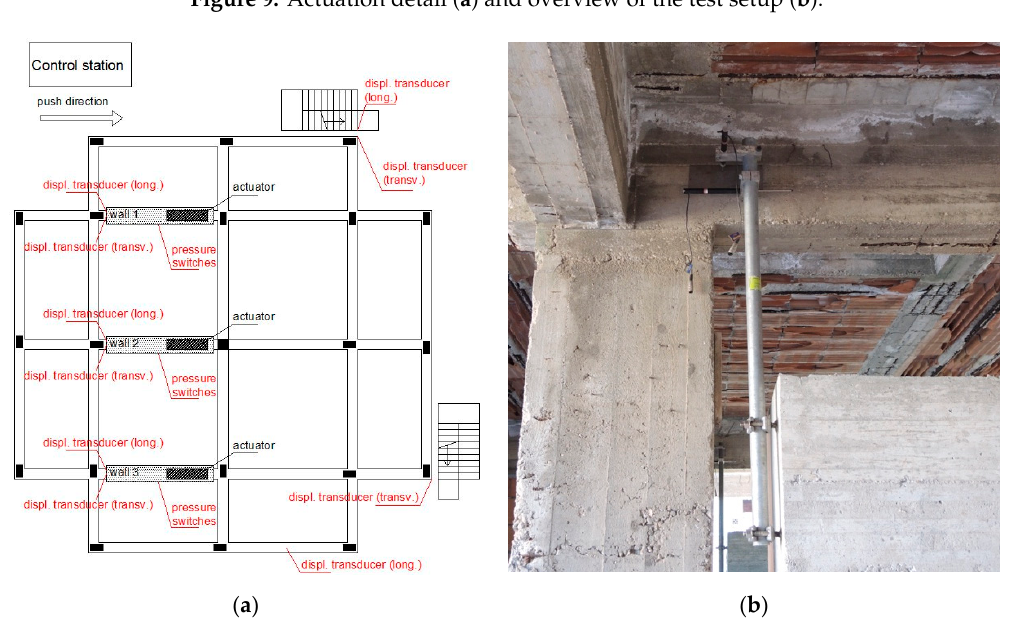
Figure 9. Actuation detail ( a ) and overview of the test setup ( b ). Buildings 2020 , 10 , x FOR PEER REVIEW